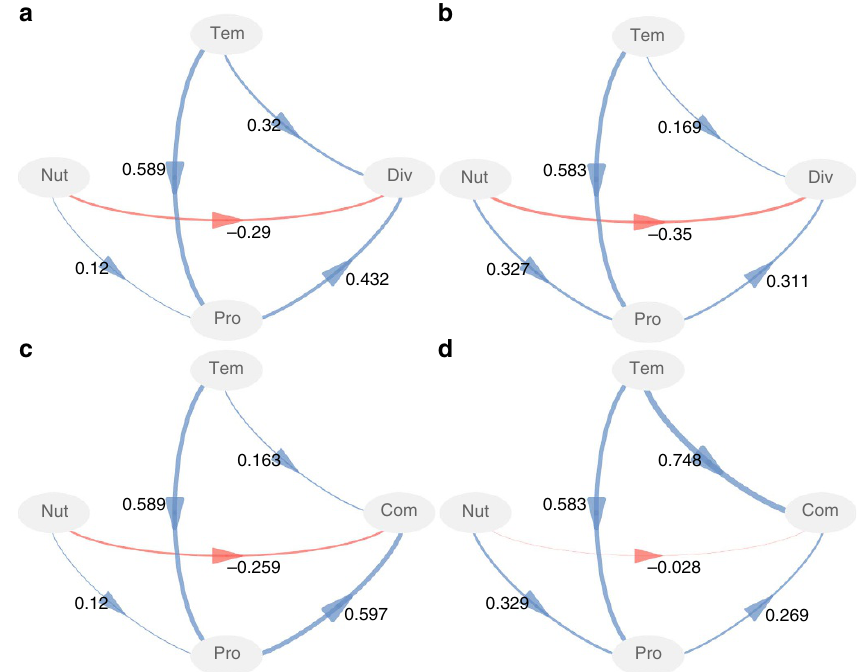
Figure 4 | The direct and indirect effects of temperature and nutrients on biodiversity. The effects of temperature (Tem), nutrient enrichment (Nut) and primary productivity (Pro) on bacterial diversity (Div) and community composition (Com) for Norway ( a , c ) and China ( b , d ), explored with partial least squares path model. For diversity ( a , b ) and community composition ( c , d ), species richness and the first axis of nMDS were used as observed variables. For temperature, water temperature and its squared value were used. For nutrient enrichment, the observed variables included the initial levels of added NO 3 (cid:3) and measured NO 3 (cid:3) , NO 2 (cid:3) and PO 4 3 þ . For primary productivity, the observed variables were pH and Chl a . Shown are the path coefficients calculated after 1,000 bootstraps. Models were assessed using goodness of fit (GoF) statistic. The GoFs for A-D are 0.630, 0.520, 0.622 and 0.718,